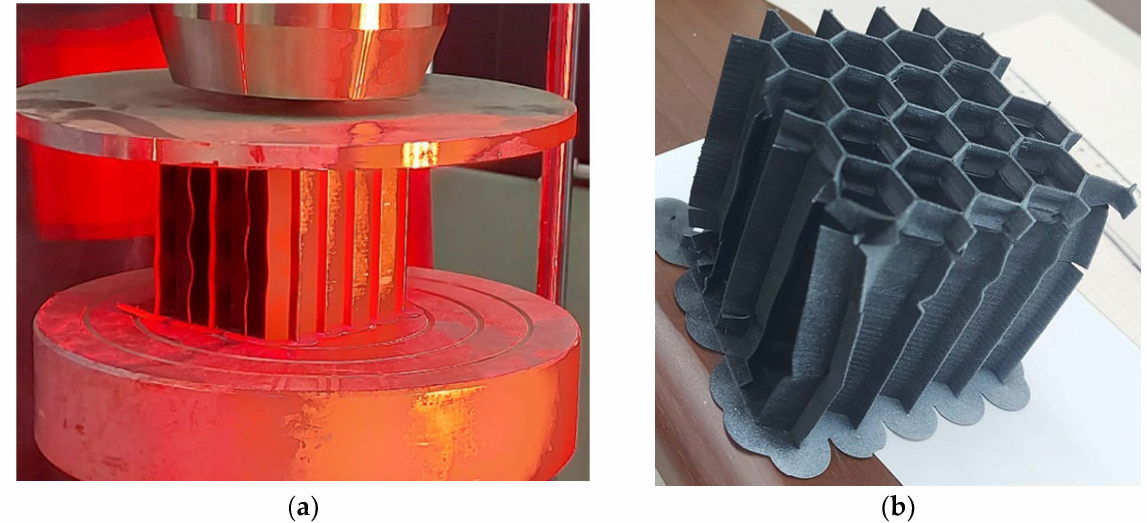
Figure 20. Compression test of CPE honeycomb specimen ( a ) Buckling of external walls ( b ) Specimen after failure.